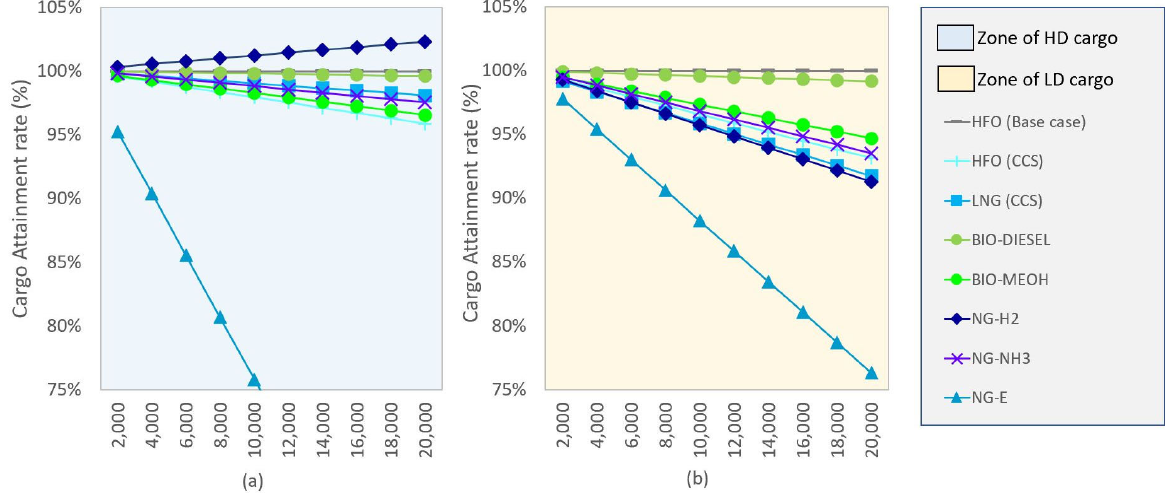
Figure 7. Cargo attainment rate (mass) versus voyage distance (n.m.) for various fuels, for HFO- fuelled containership; ( a ) when the ship is mass critical with SF 0.75 m 3 /ton, and ( b ) when the reference ship is volume critical with SF 1.25 m 3 /ton.